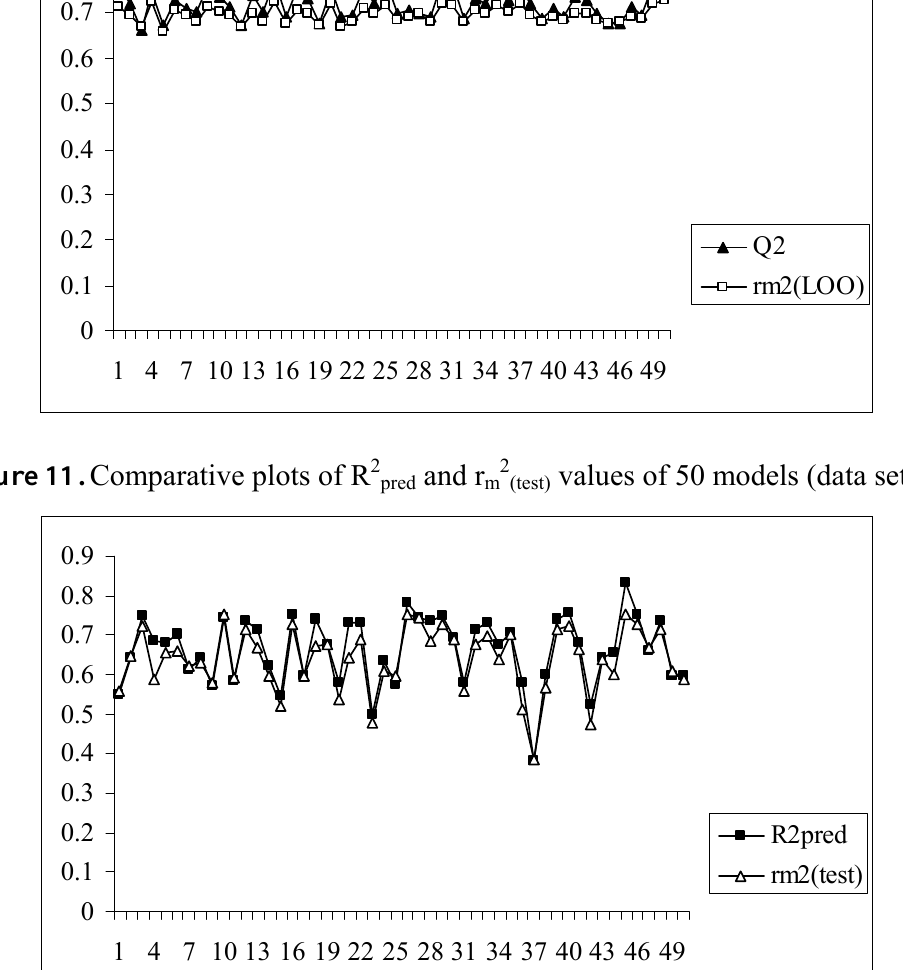
values of 50 models (data set III). (LOO)